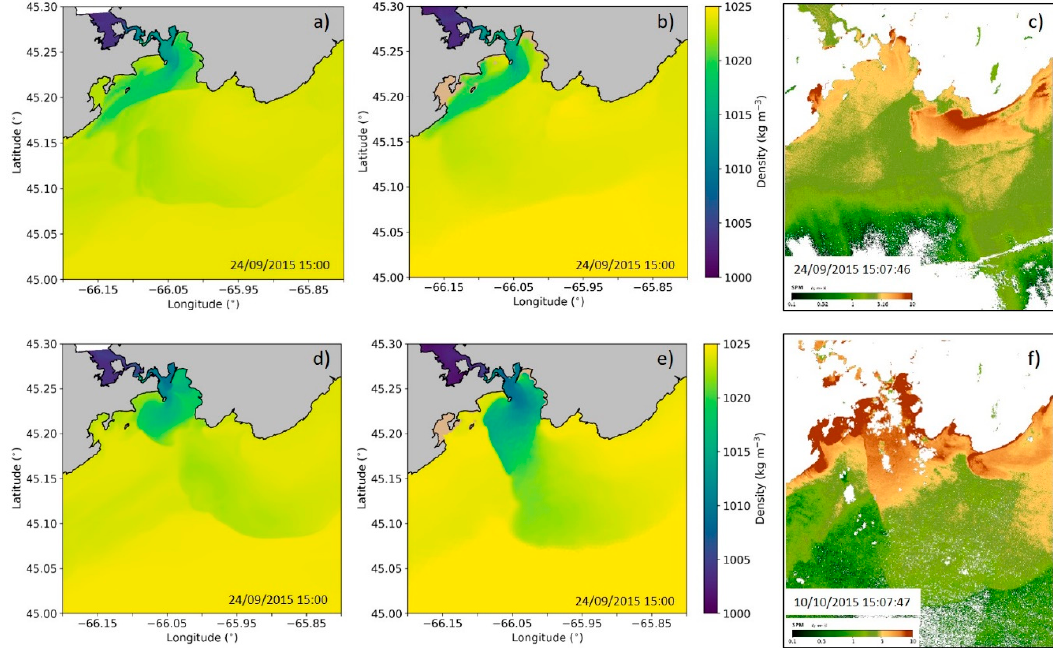
Figure 6. Snapshot of the surface density (kg m − 3 ) from the NEMO ( a , d ), and the FVCOM ( b , e ) within 15 min of the satellite-derived images of suspended particulate matter ( c , f ) provided by E. Devred, Fisheries and Oceans Canada (DFO). The dates and times of the satellite images, as well as the modelled surface density field are indicated.